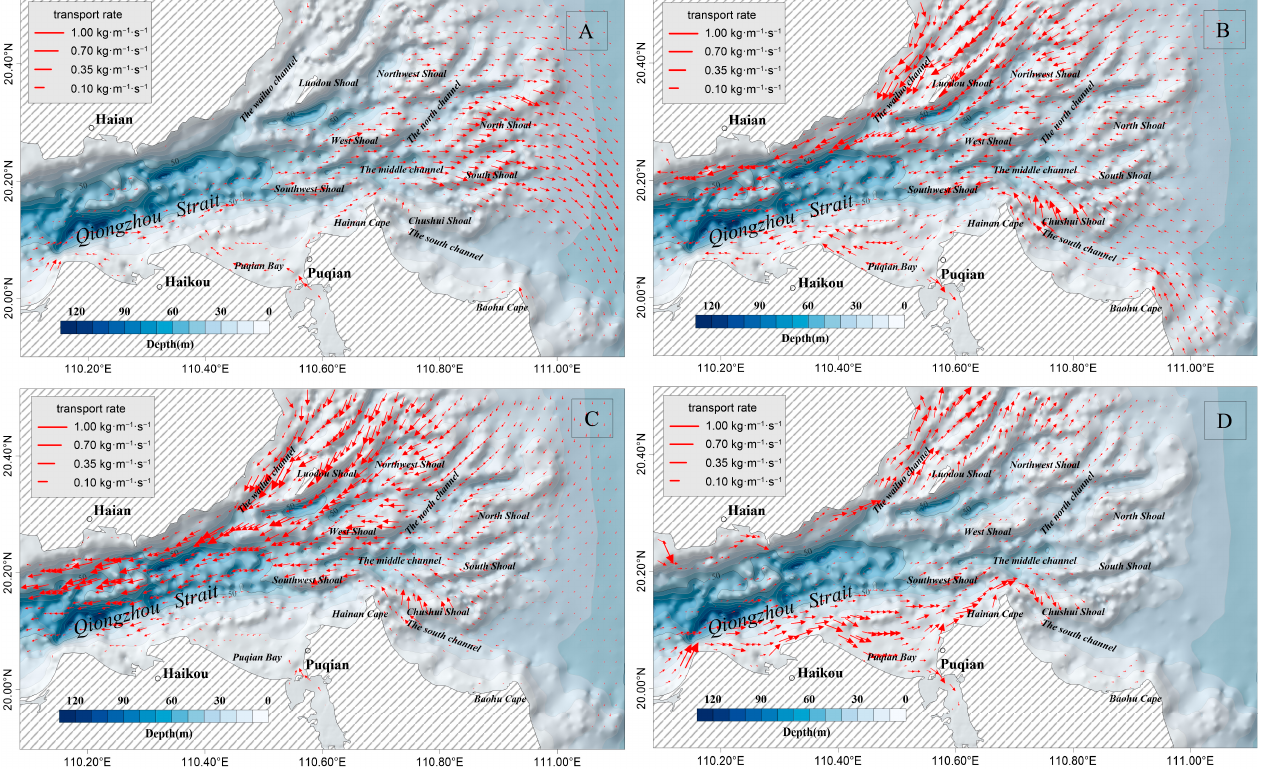
Figure 8. Characteristics of bedload transport rate at the east entrance of the Qiongzhou Strait during different tidal phases. ( A ) Eastward ebb current, ( B ) westward flood current, ( C ) westward ebb current, ( D ) eastward flood current.